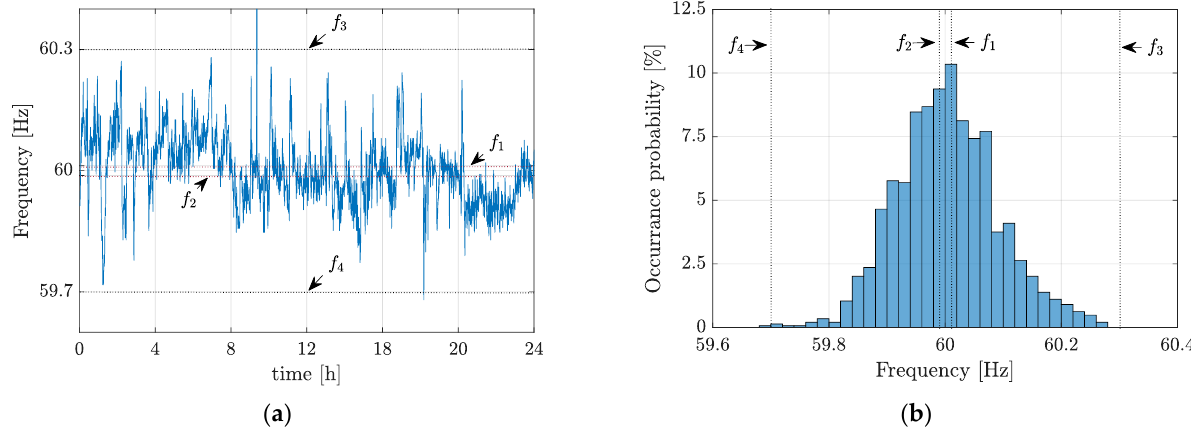
Figure 4. Reference frequency data: ( a ) one-day frequency profile; ( b ) occurrence probability of the frequency excursion.